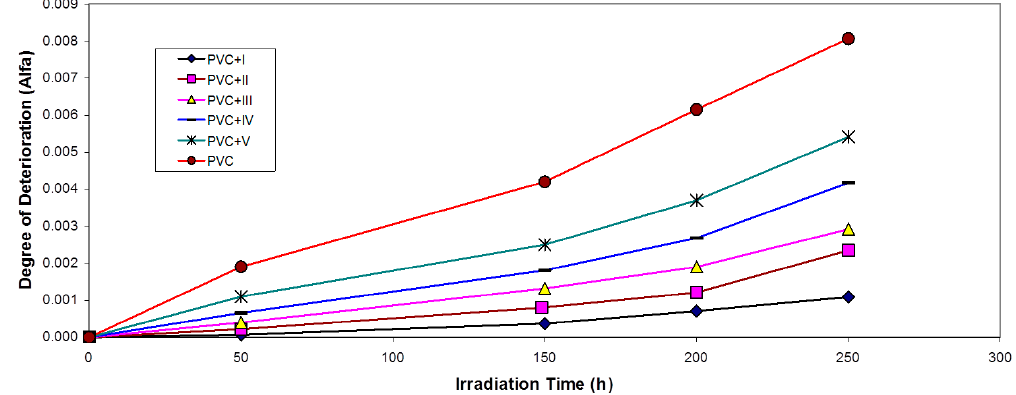
Figure 5. Changes in the viscosity average molecular weight (M v ) during irradiation of PVC films (30- µ m) (control) and with 0.5 wt % of additives.